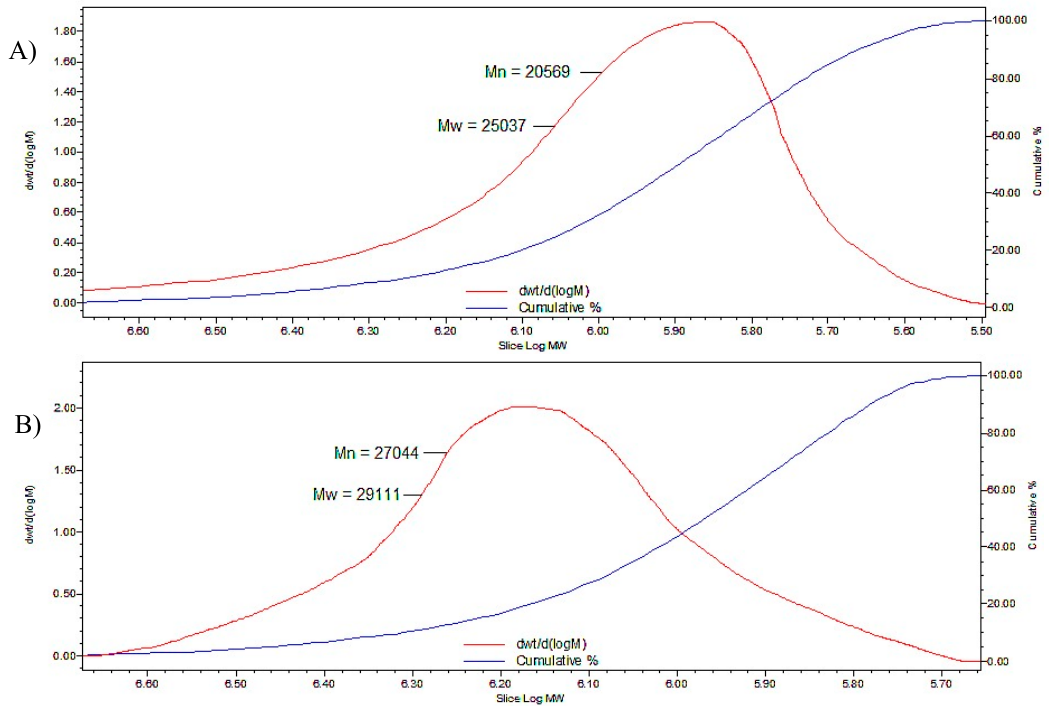
Figure 4. GPC data (molecular weight distribution and cumulative percent curves) for: ( A ) pectin and ( B )